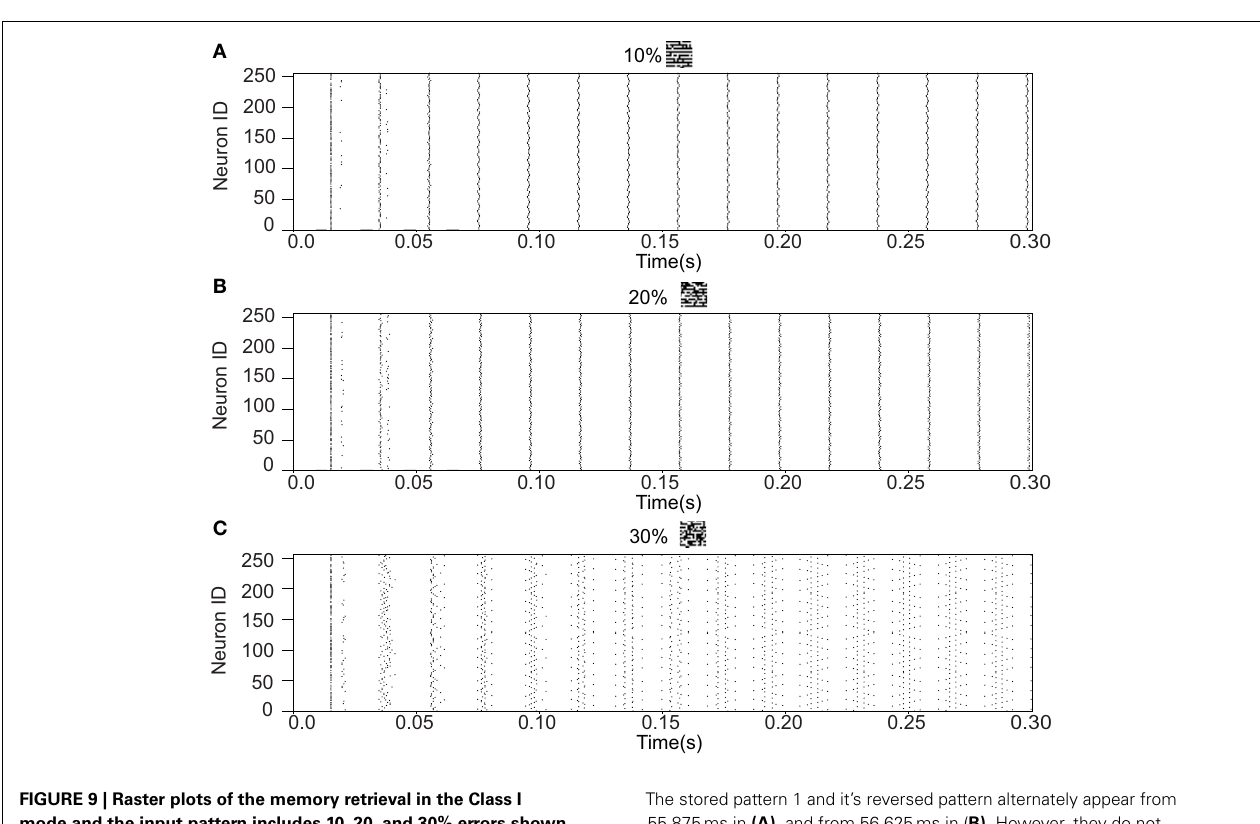
FIGURE 9 | Raster plots of the memory retrieval in the Class I mode and the input pattern includes 10, 20, and 30% errors shown in Figure 8B. The input pattern is observed at 15.375ms in both (A–C) .